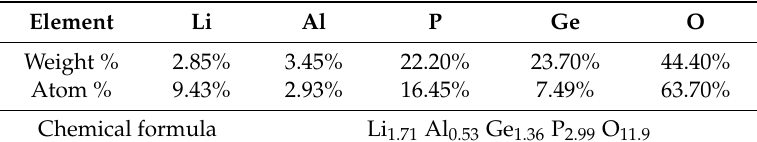
Table 2. Chemical analysis and composition of the prepared LAGP